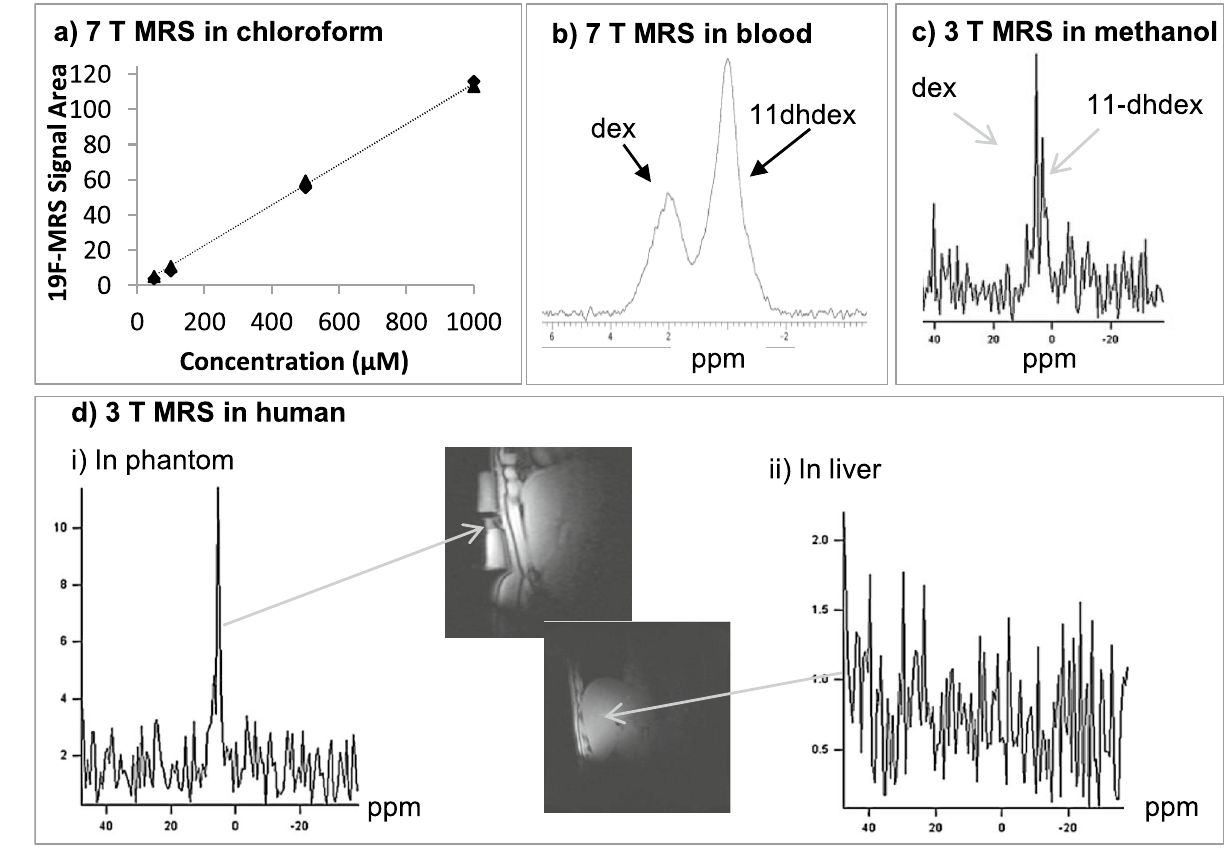
Figure 2. Evaluation of 11-dehydrodexamethasone as a tracer for 11β-HSD1 activity by 19 F-MRS. (a) Linearity of 19 F-MRS signal vs concentration (50–1000 µM) ketosteroid 11-dehydrodexamethasone (11-dhdex; triangles) and hydroxysteroid dexamethasone (dex; rhombi). (b) Broadening and overlap of peaks in whole blood biological matrix (5 mL) with 2.1 mg dex plus 4.2 mg 11-dhdex scanned on the Agilent 7T